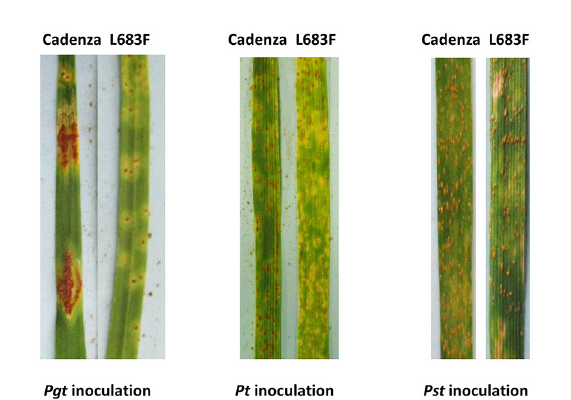
FIGURE4 Reactions of the wild-type Cadenza and the TaMYC4 mutant L683F after inoculation with Puccinia graminis f. sp. tritici ( Pgt ), P. triticina ( Pt ) and P. striiformis f. sp. tritici ( Pst ) inoculation. Infection types (IT) of Cadenza: L683F in each pair of images were, Pgt (4: 1 + ), Pt (3: 2-;) and Pst (4: 3c) Photos of Pgt and Pst inoculated plants were taken 14 days post inoculation. Photos of Pt inoculated plants were taken 9 days post